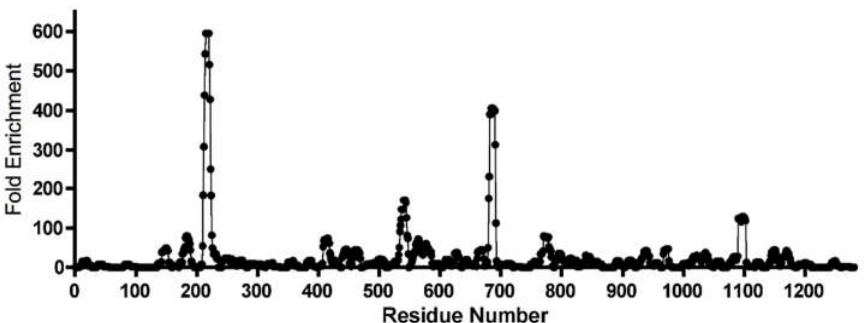
Figure 2. One example of affinity-selection of epitopes from a SARS-CoV-2 antigen fragment library. Peptide-VLPs were enriched by affinity-selection on serum with high neutralization activity from a single patient. Individual peptides were identified and their relative abundances relative to non- neutralizing sera were determined by Ion Torrent sequence analysis. Their positions in the spike protein amino acid sequence (x-axis) are plotted against their relative enrichment (y-axis). Similar plots were obtained for spike and other viral structural proteins and with serum from a number of patients (not shown). Those results will be joined with these as part of a fuller analysis to be presented elsewhere.